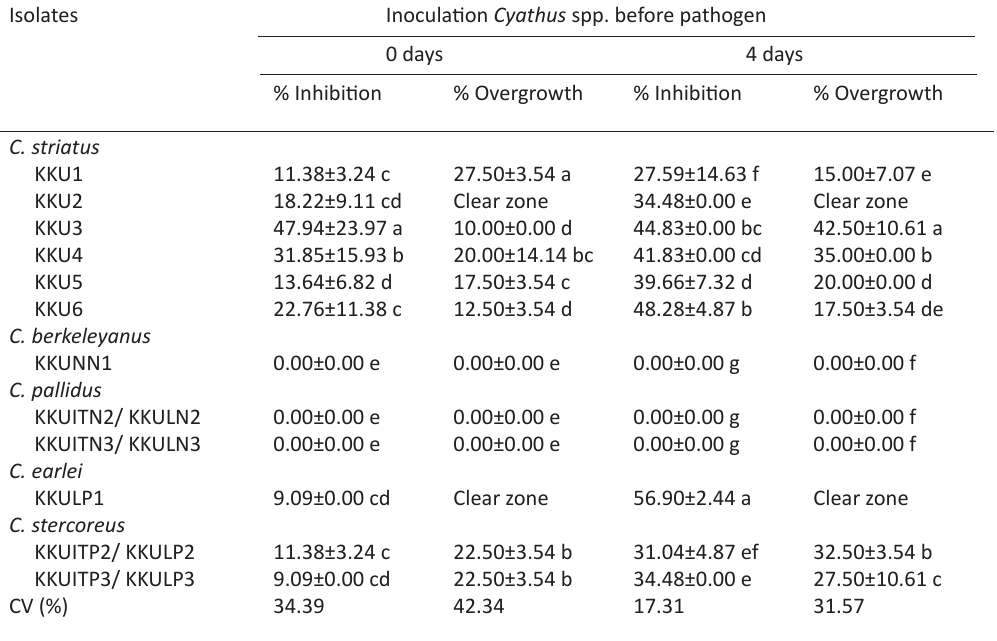
Table 2. Efficacy of Cyathus spp. controlling Fusarium sp. by dual culture technique. Isolates Inoculation Cyathus spp. before pathogen 0 days 4 days